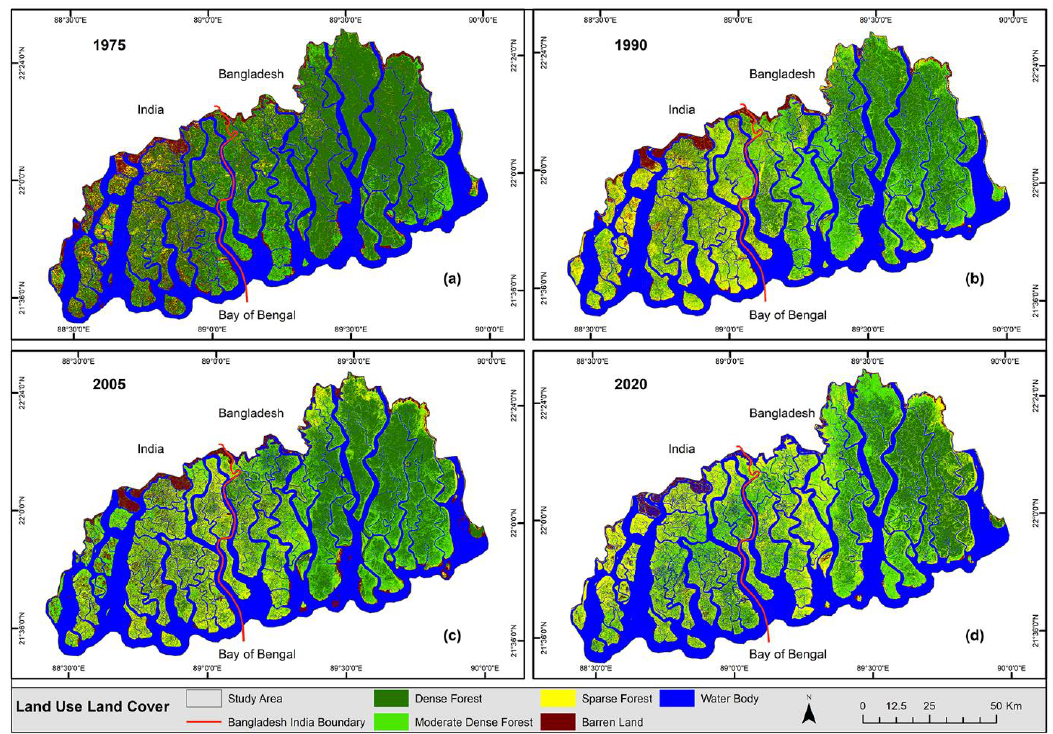
Figure 2. LULC of Bangladesh and Indian Sundarbans from 1975 to 2020 (red line is the boundary between Bangladesh and India)